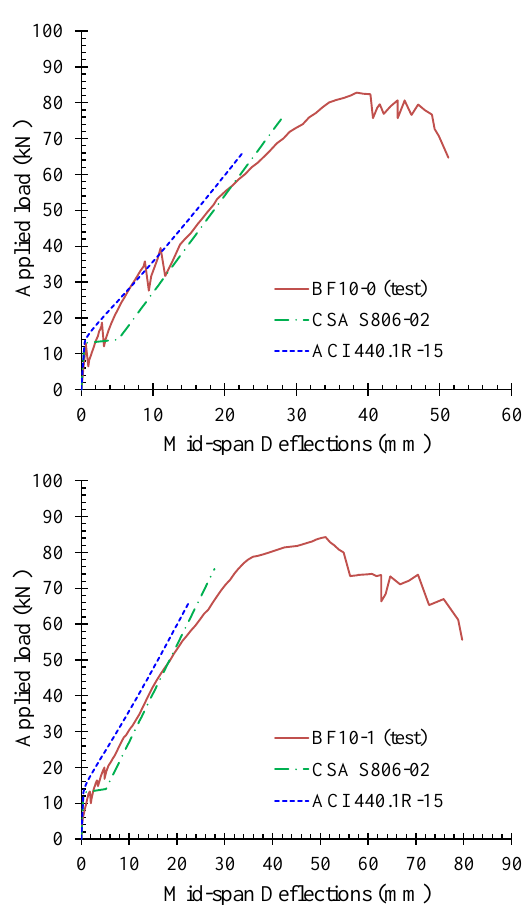
Figure 12. Comparisons of the test results with the predictions according to ACI 440.1R-15 and to CSA S806-12 for beams BF10-0 and BF10-1. FRP reinforcement of series “BF10” beams: ρ f = 0.39%.